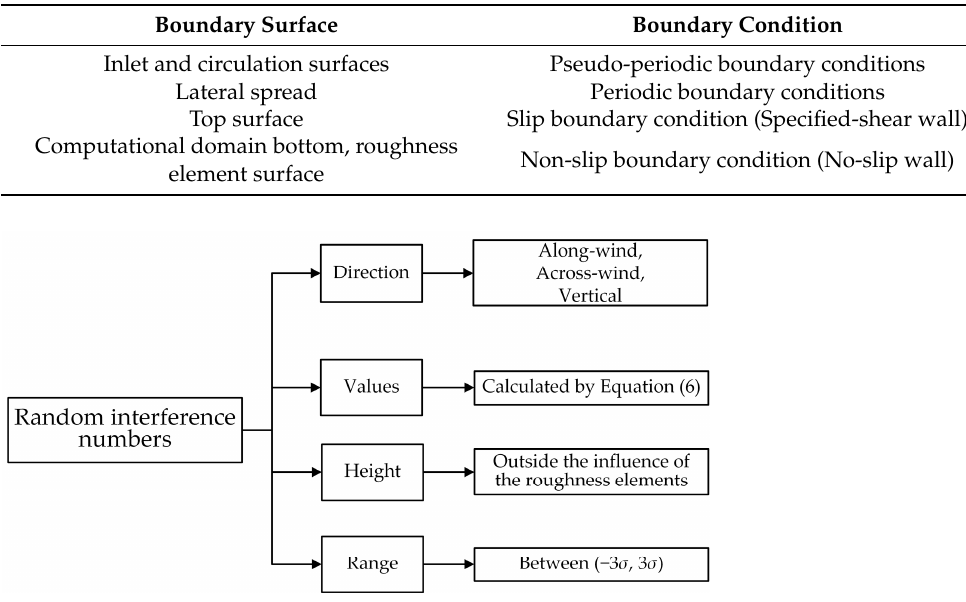
Figure 4. The summary of random interference number